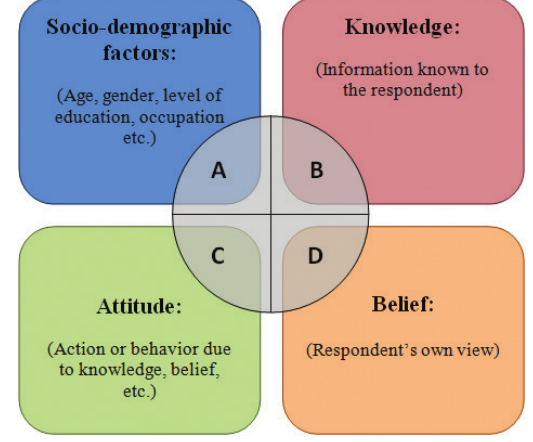
Figure 2. Interfacing of four areas of questionnaire.